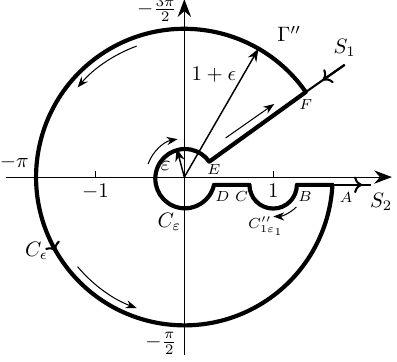
Figure 4. The auxiliary contour of integration Γ (cid:48)(cid:48)